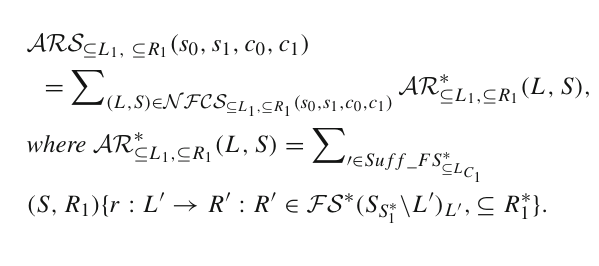
(see Fig. 5) to efficiently mine the set of all association rules withmaximumsingleconstraints ARS ⊆ L from lattice LCG